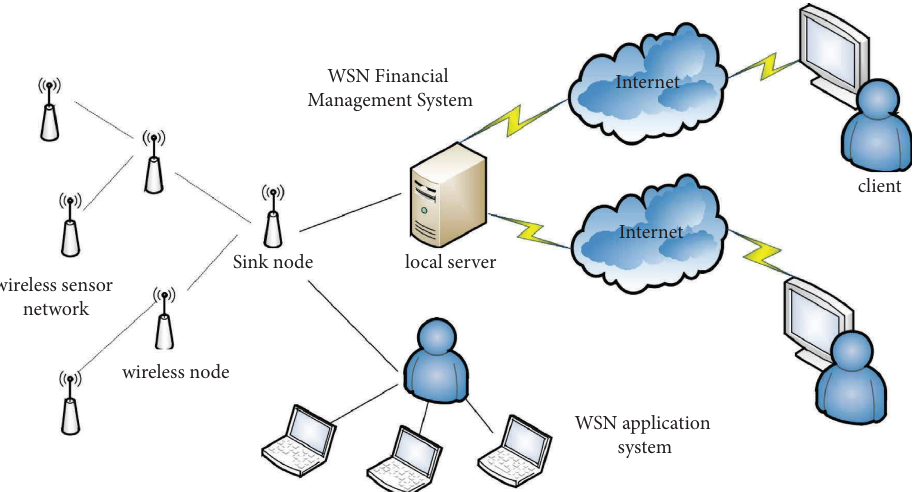
Figure 6: Core functions and business fowchart of accounts receivable